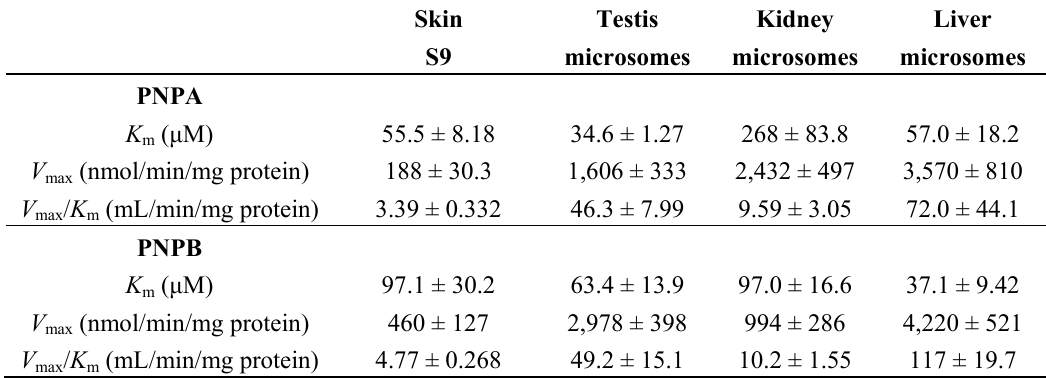
Table 1. Kinetic parameter for hydrolysis of PNPA and PNPB in rat skin S9, testis, kidney, and liver microsomes. Skin Testis Kidney Liver S9 microsomes microsomes microsomes